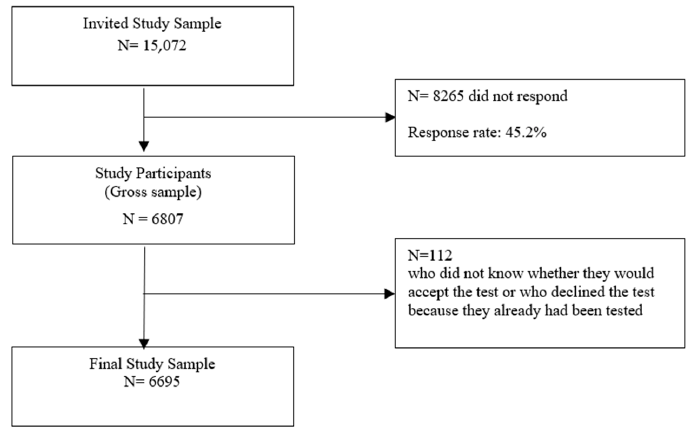
Figure 1. Flow chart on Study Sample Size.